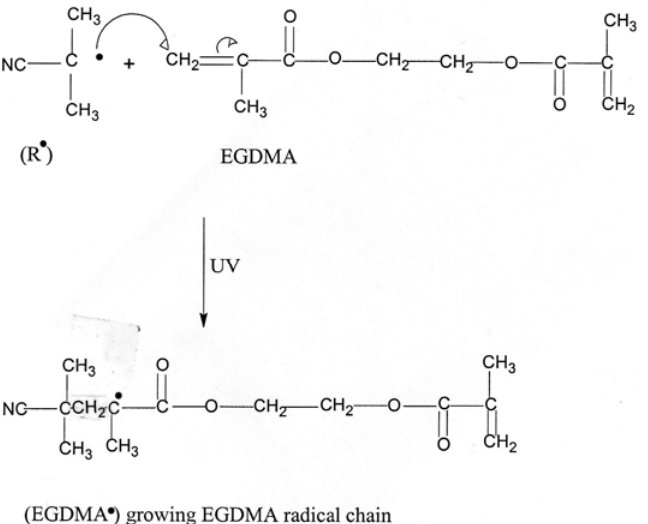
Figure 2. Formation of growing EGDMA